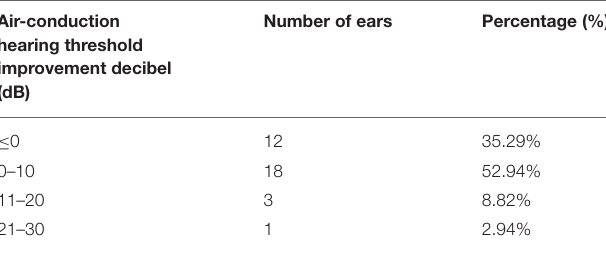
TABLE 3 | Air conductance threshold improvement before and 4 weeks after hydrogen and oxygen inhalation therapy. Air-conduction hearing